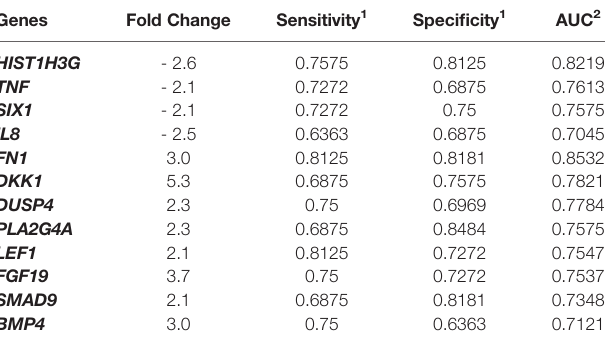
TABLE 2 | Differentially expressed genes between the recurrence and nonrecurrence groups. Genes Fold